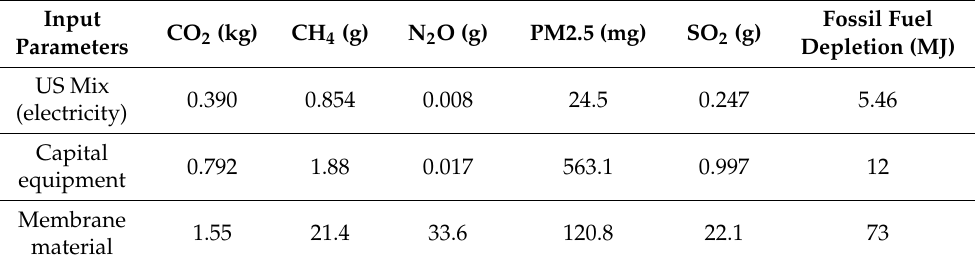
Table 2. LCI data to produce 1 kWh of electricity using US Mix, capital equipment, and membrane